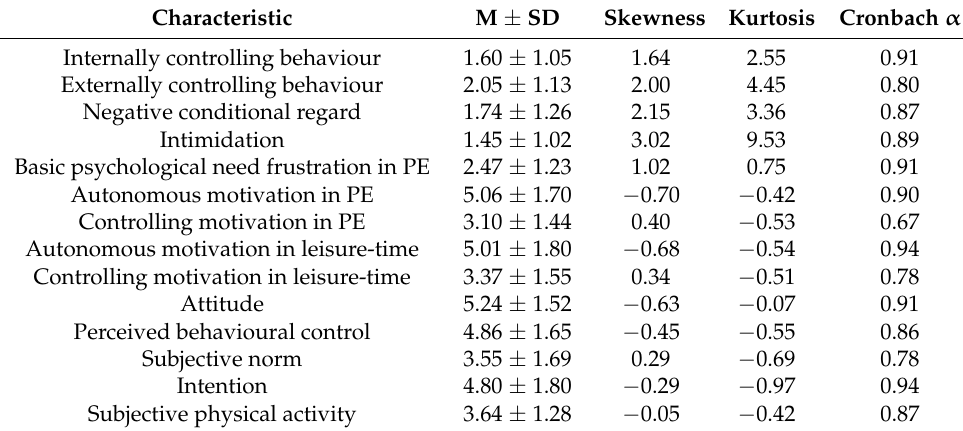
Table 1. Descriptive statistics on survey characteristics ( n =